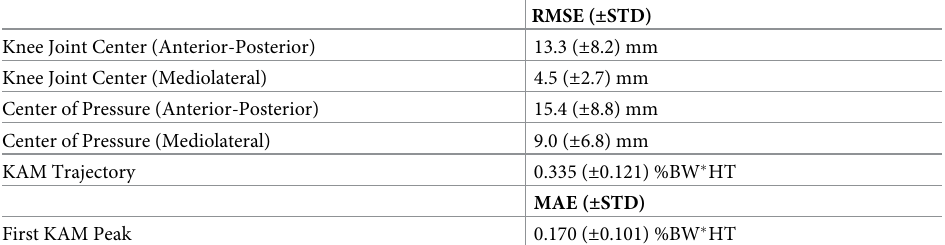
Table 3. Validation of the learned gait patterns using the Carnegie Mellon University